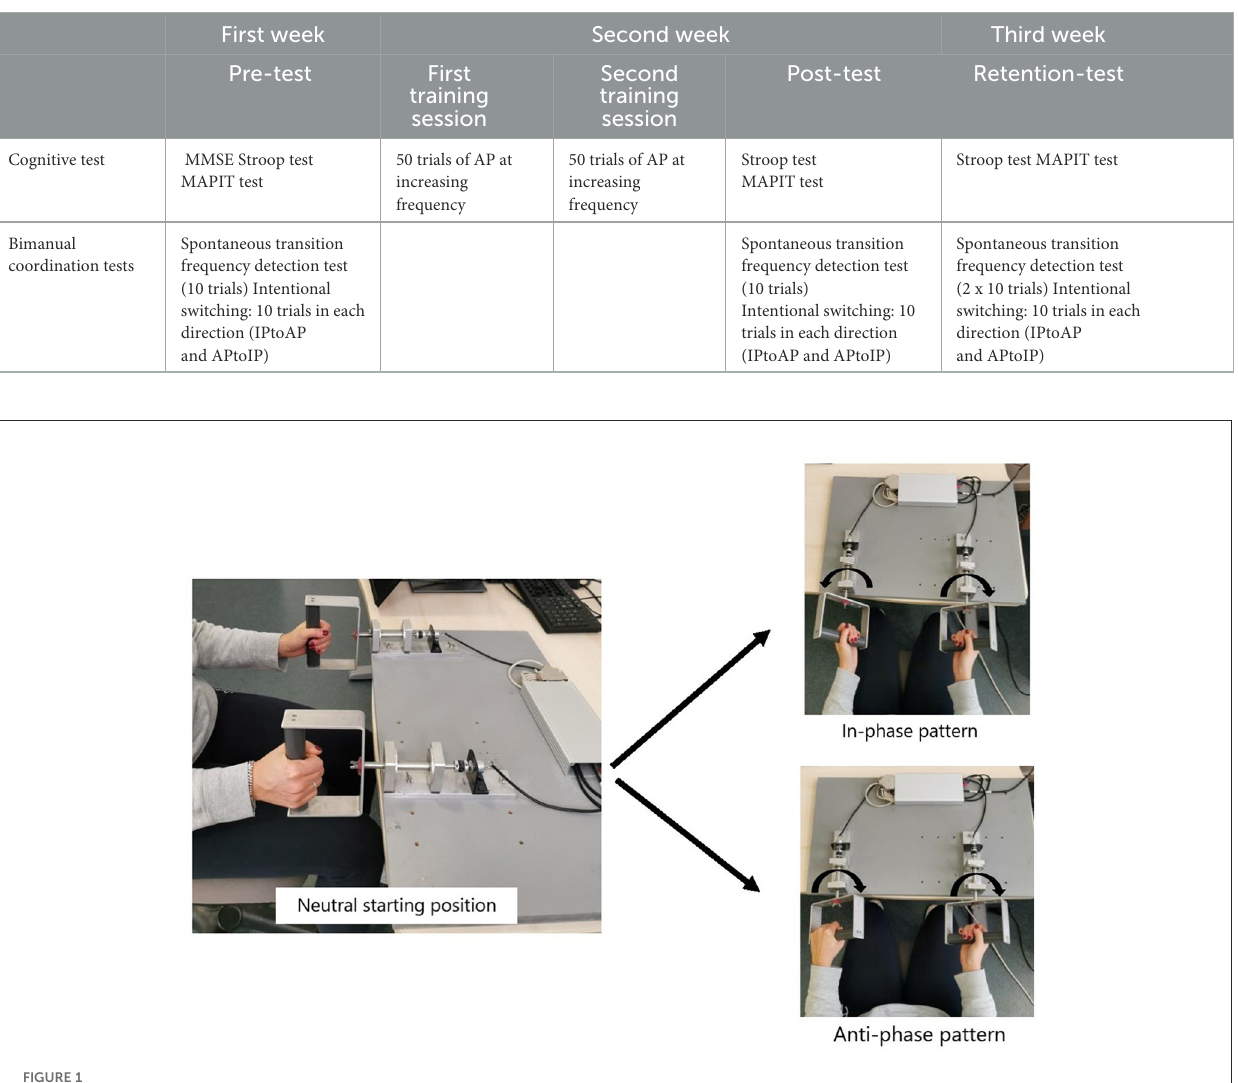
participants to change as fast as possible from the ongoing pattern to the other one. Each trial lasted 30